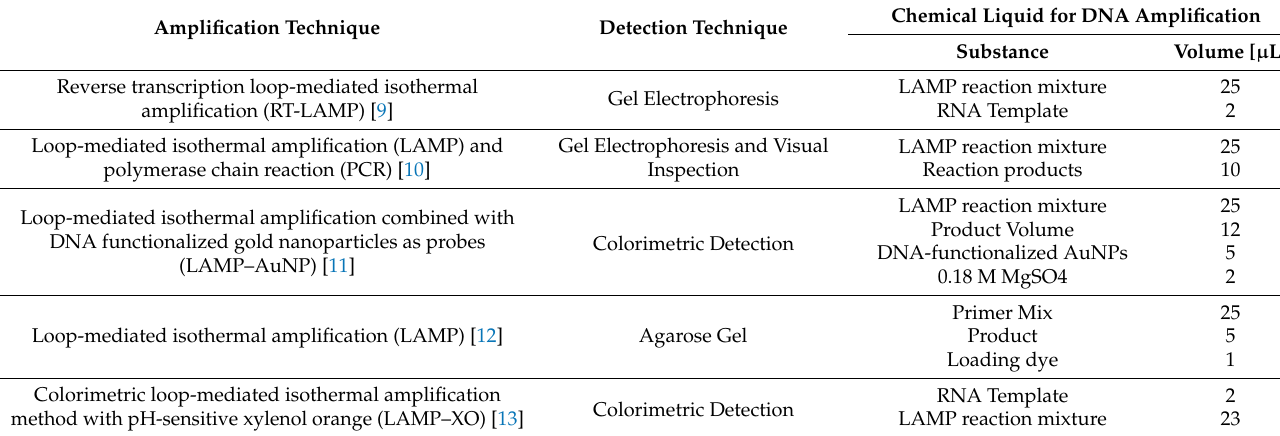
Table 1. Droplet sizes for loop-mediated isothermal amplification method (LAMP) DNA/RNA amplification and detection in a normal